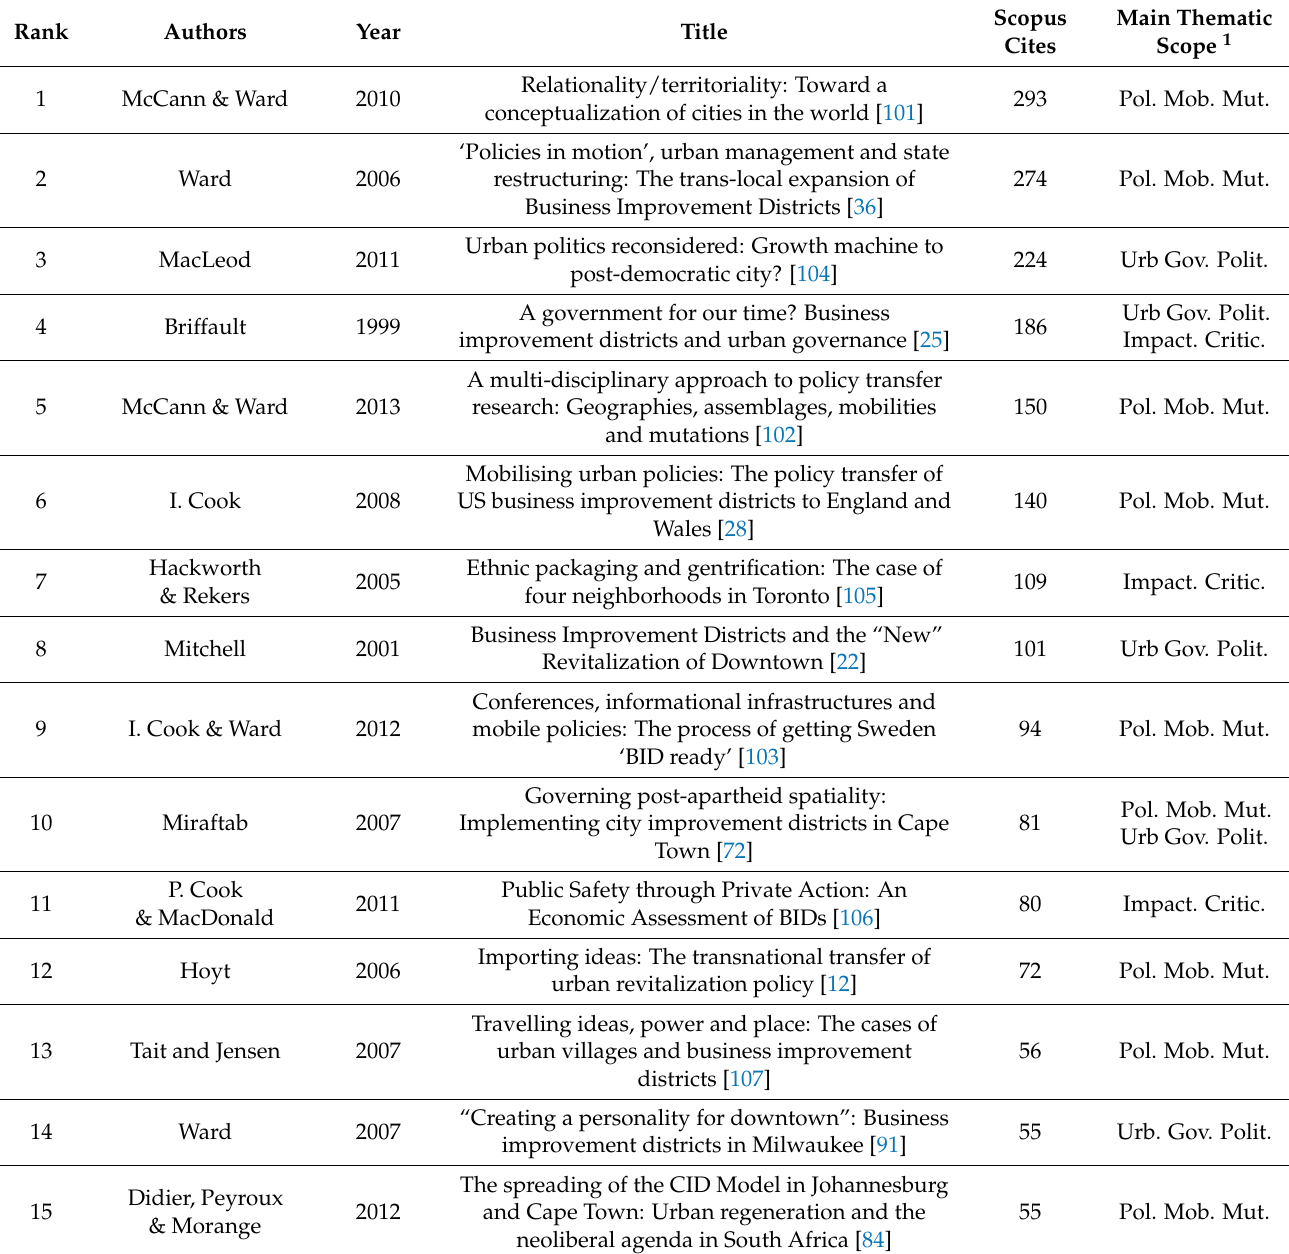
Table 5. Most relevant documents published on BIDs,